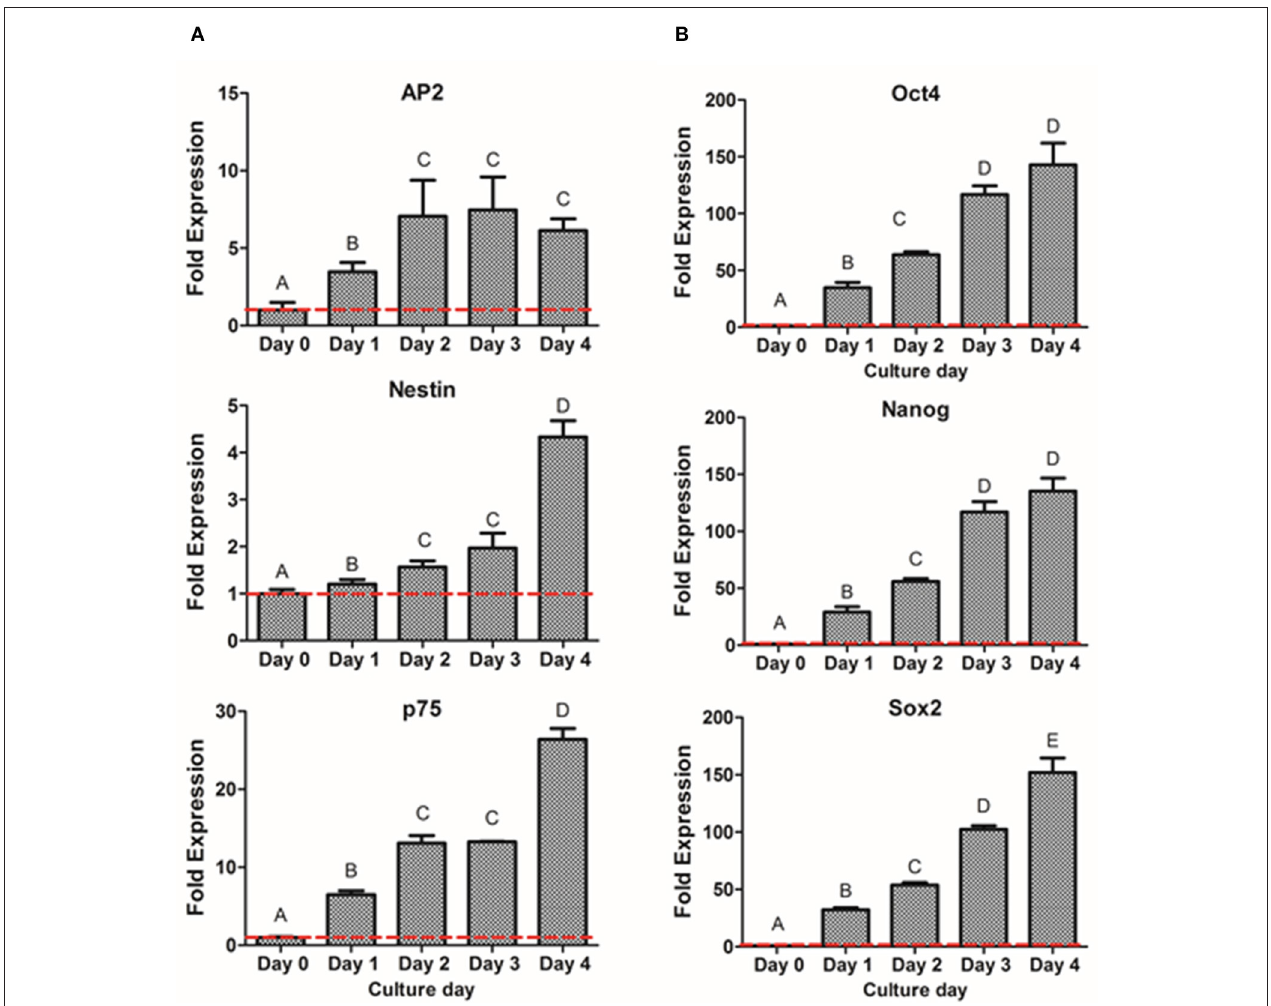
FIGURE 5 | Gene expression of NCSC formation from DPSC in suspension culture. Relative mRNA expression of NCSC markers AP2, Nestin, and p75 (A) and pluripotent markers Oct4, Nanog, and Sox2 (B) analyzed by quantitative RT-PCR. *Data presented are means ± SD, n = 3 technical replicates. Different letter denotes significant differences ( p < 0.05). Same letter denotes non-significant